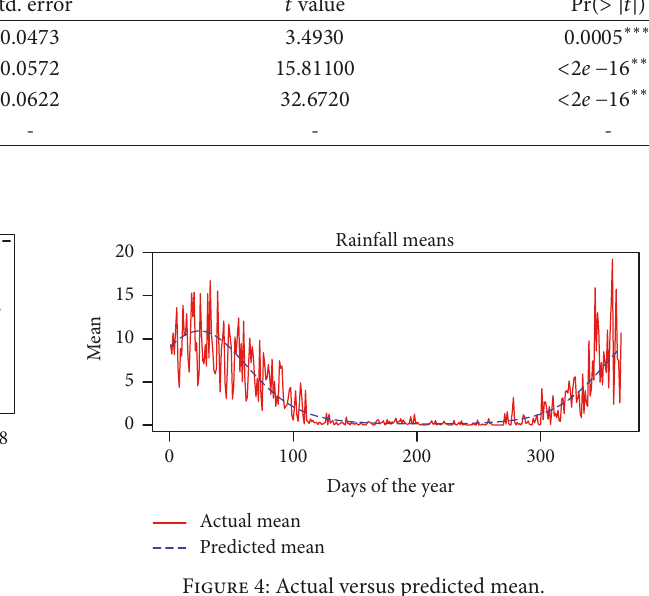
Figure 4: Actual versus predicted